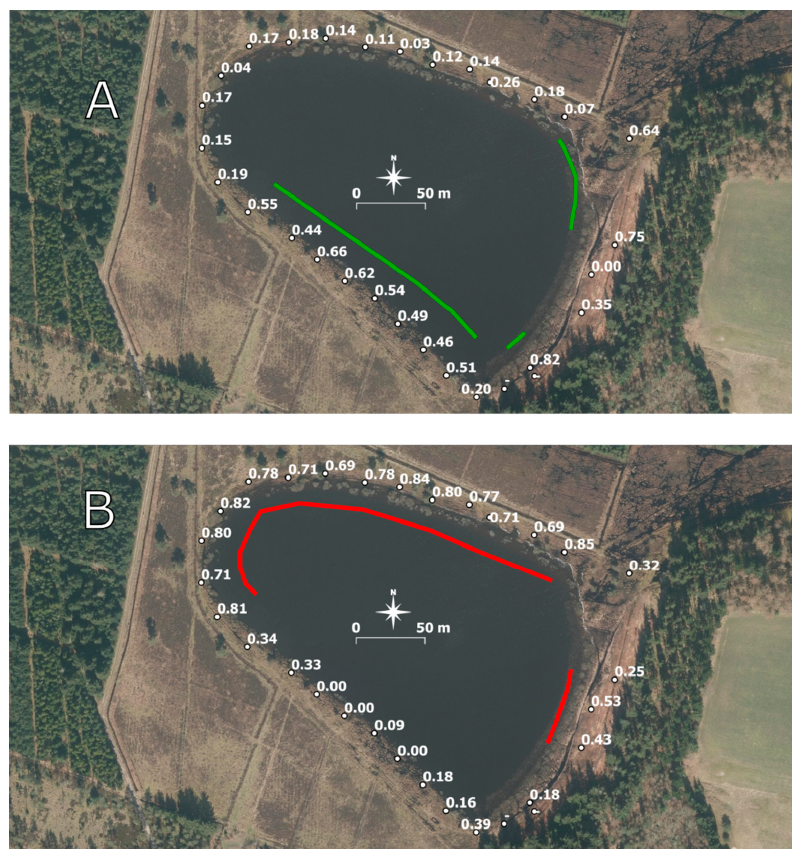
Figure 9. Fraction of samples coming from ( A ) groundwater (green lines show interpreted discharge segments)